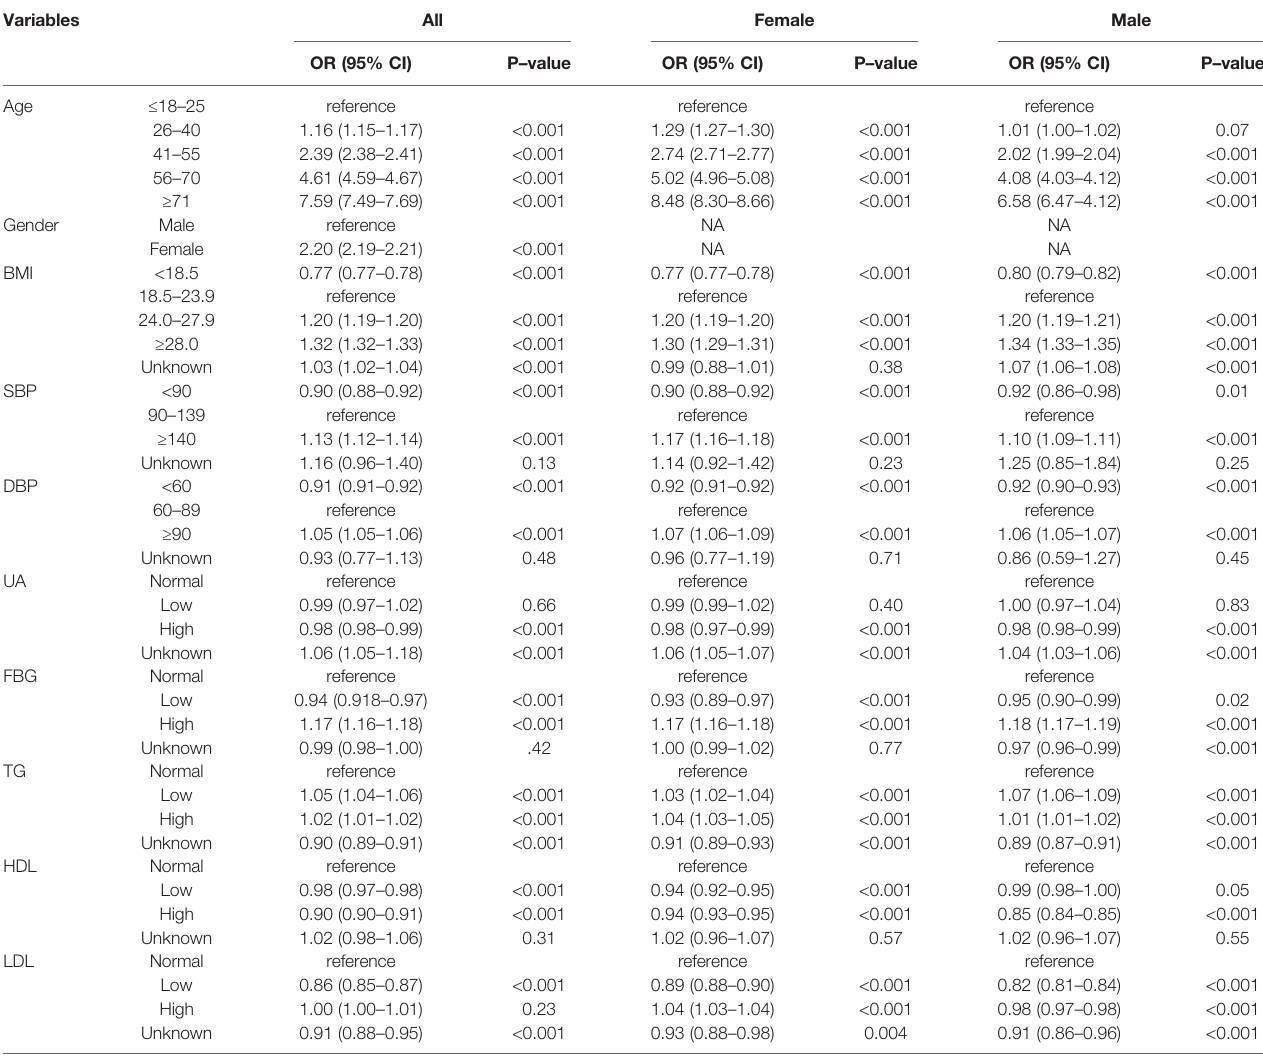
TABLE 2 | Multivariable logistic regression